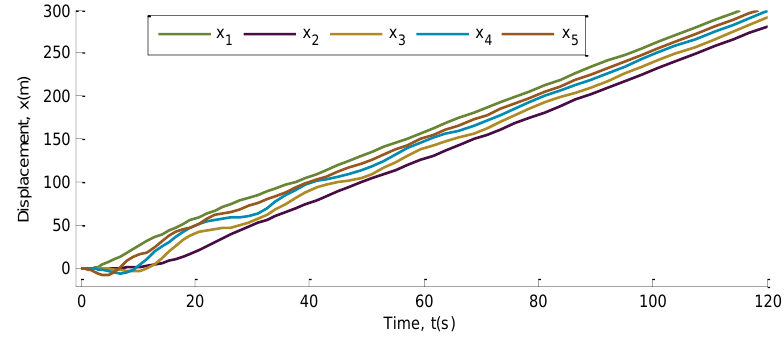
Figure 8. Displacement curves (Case 2)